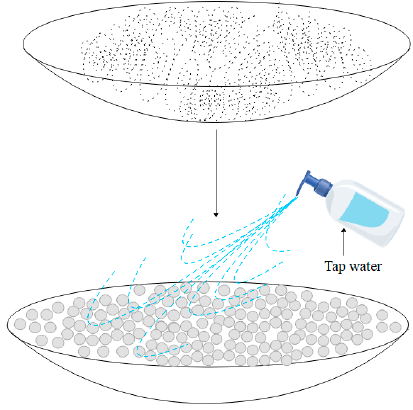
Figure 2. Preparation process of swelled SAP.